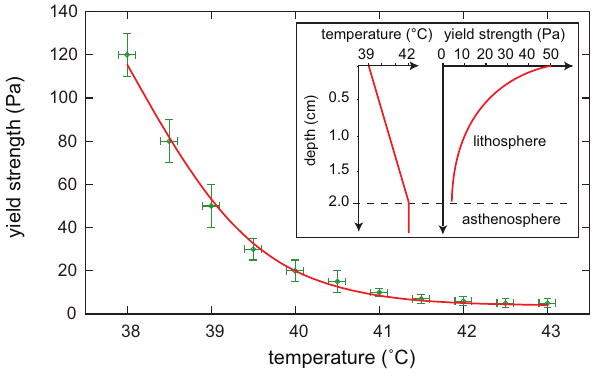
Fig. 5. The material thermal diffusivity is fitted with a 1-D cool- ing solution. The best fit provides a thermal diffusivity of 2 . 8 × 10 − 8 m 2 s − 1